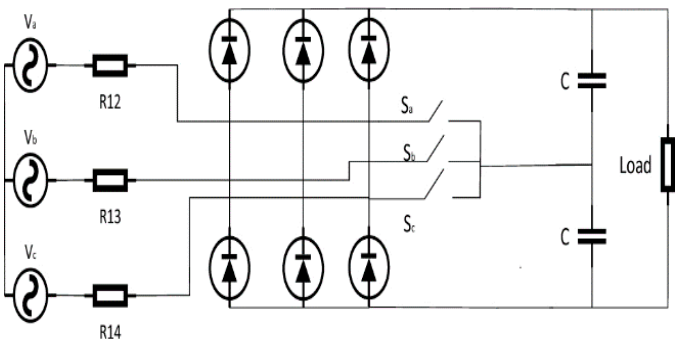
Figure 5. Vienna Rectifier [37].